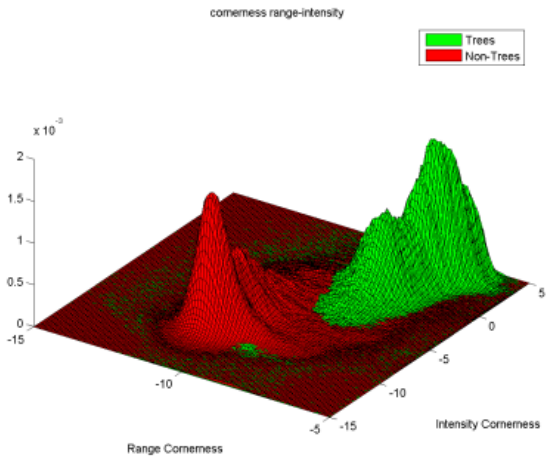
Figure 13. 2D distribution of the combined range and the intensity cornerness cues. The 2D feature space is made of 100 × 100 bins; each bin represents the rate of this cue set appearance in the training set.